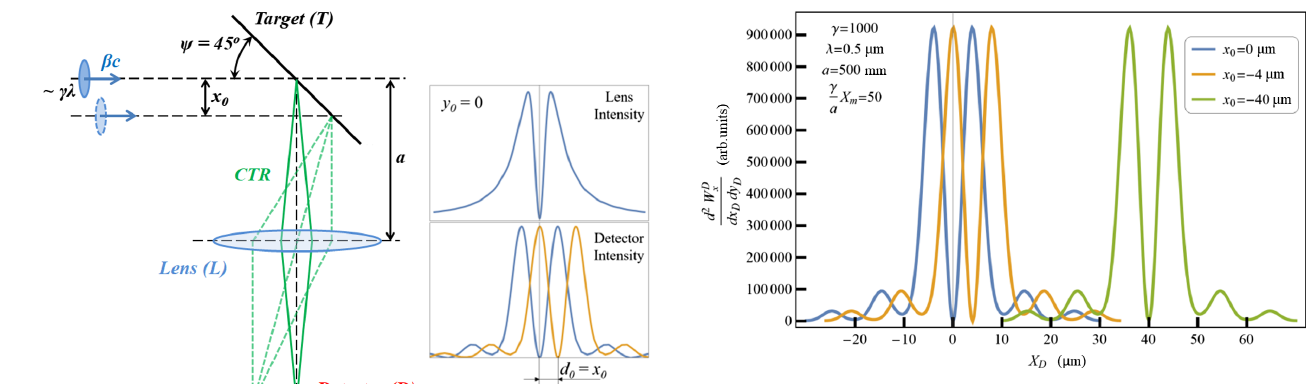
FIG. 2. OTR image distributions generated from electrons with different impact